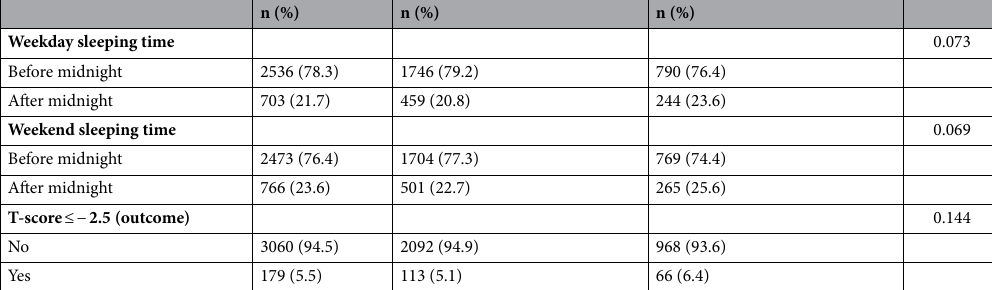
Table 1. Characteristics of the drink fermented tea and non-fermented tea groups (N = 3239). CI, confidence interval; mon, month; SD, standard deviation; BMI, body mass index; BMD, bone mineral density. p < 0.05*; p < 0.01**; p < 0.001***. a Residential urbanicity stratification was classified into urban, suburban, and rural according to the population density, ratio of educated people, age (aged ≥ 65 years), farmers, and the number of physicians per 100,000 people as defined by Liu et al. 27 . b Total tea drinking amount was divided by